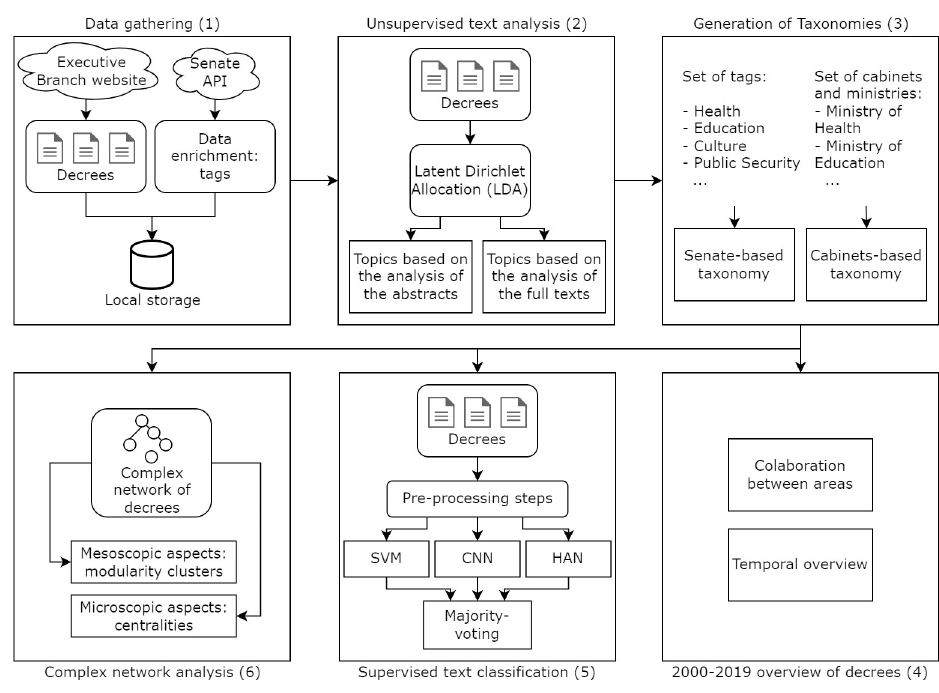
Fig 2. The framework for analysis of administrative